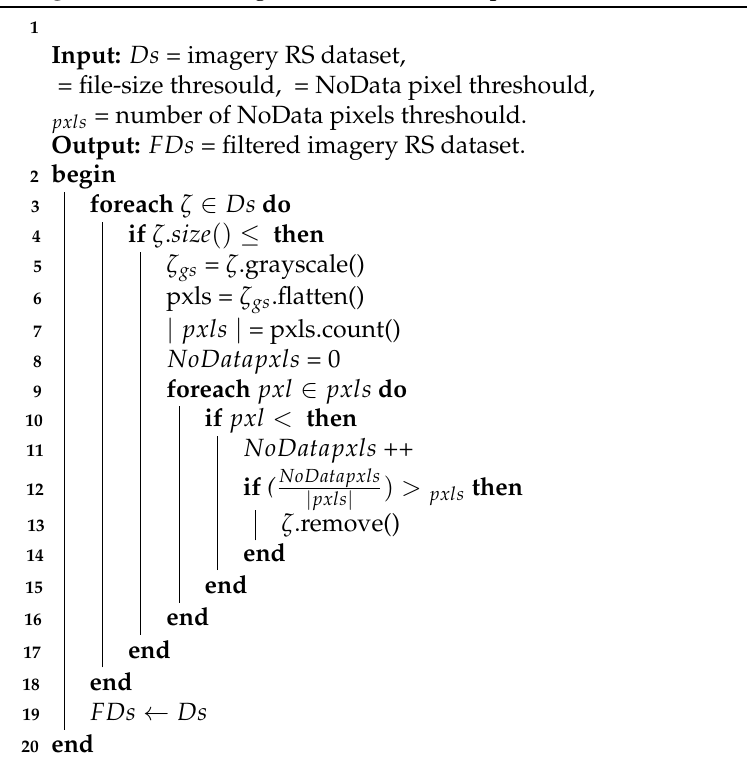
Algorithm 1: Filtering out the NoData Chips